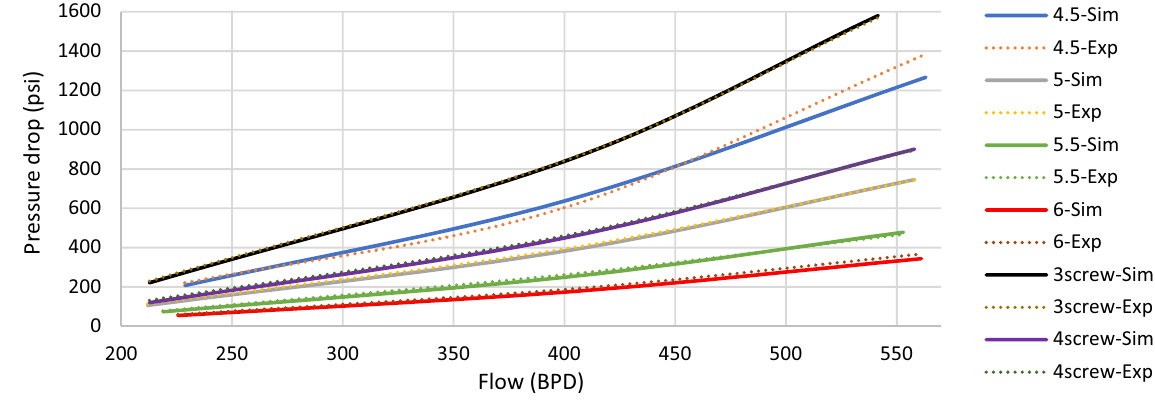
Fig. 10 Comparison between the pressure drop obtained in the CFD simulations (Sim) and the pressure drop obtained experimentally